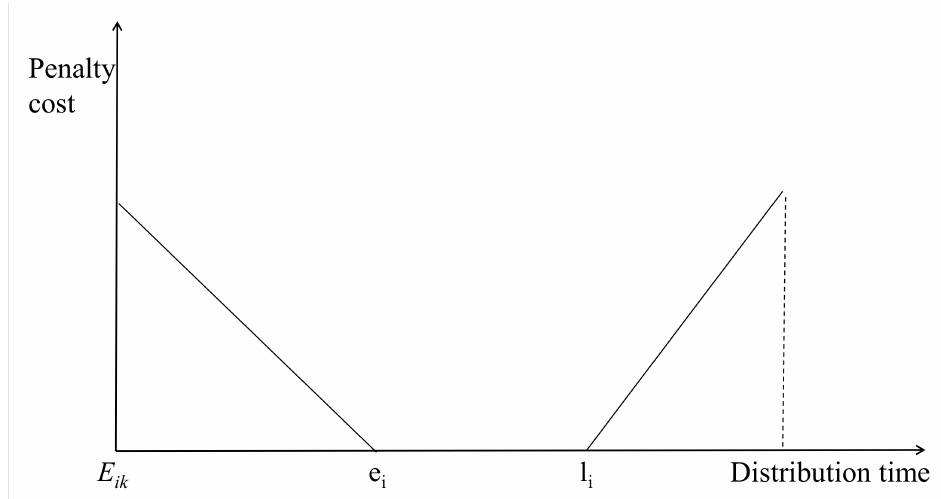
Figure 6. Penalty cost line chart.